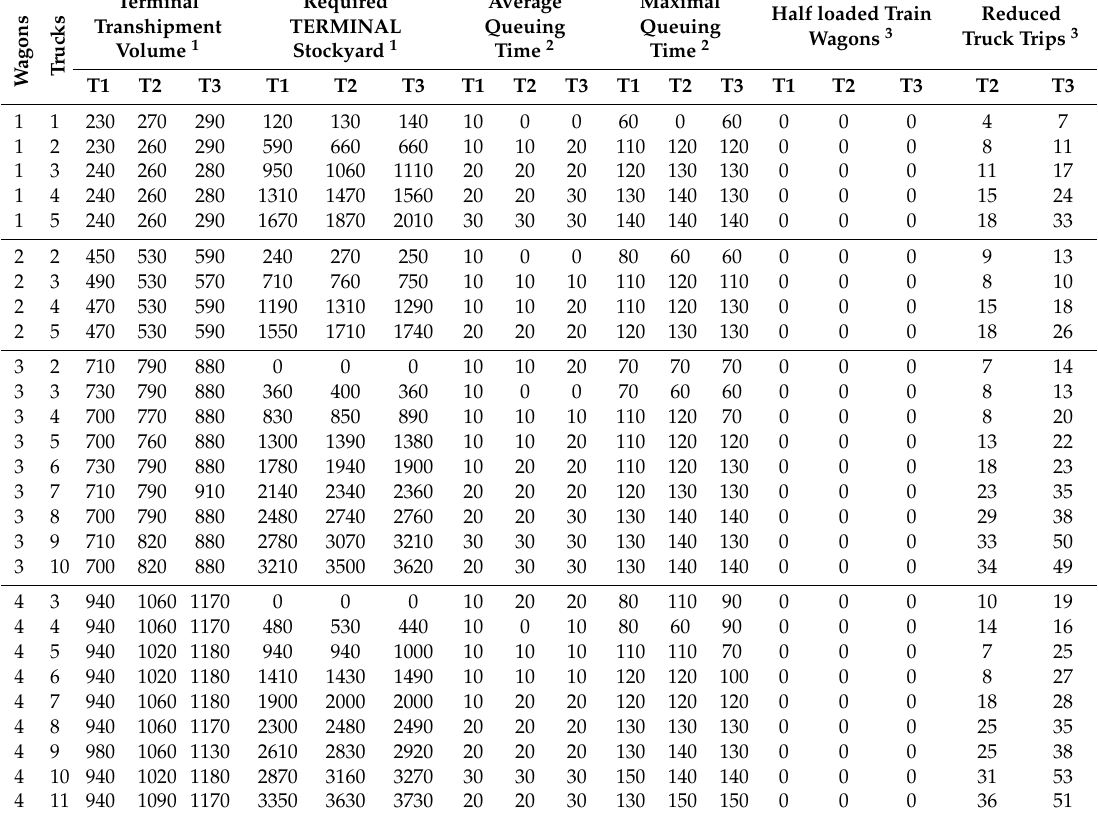
Table A1. Terminal transport template for one train pick-up, short delivery time, and all tonnages (P1D1 T1 / 2 /